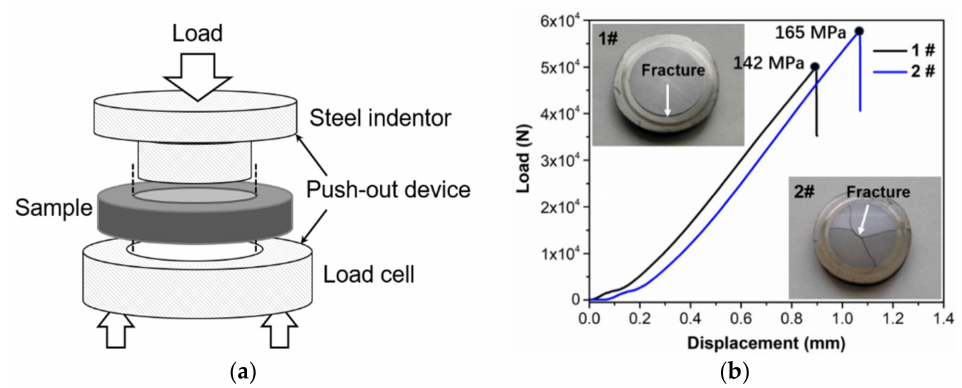
Figure 5. Bonding strength tests: ( a ) schematic diagram of the apparatus; ( b ) load-displacement curves of the V–4Cr–4Ti/Ti